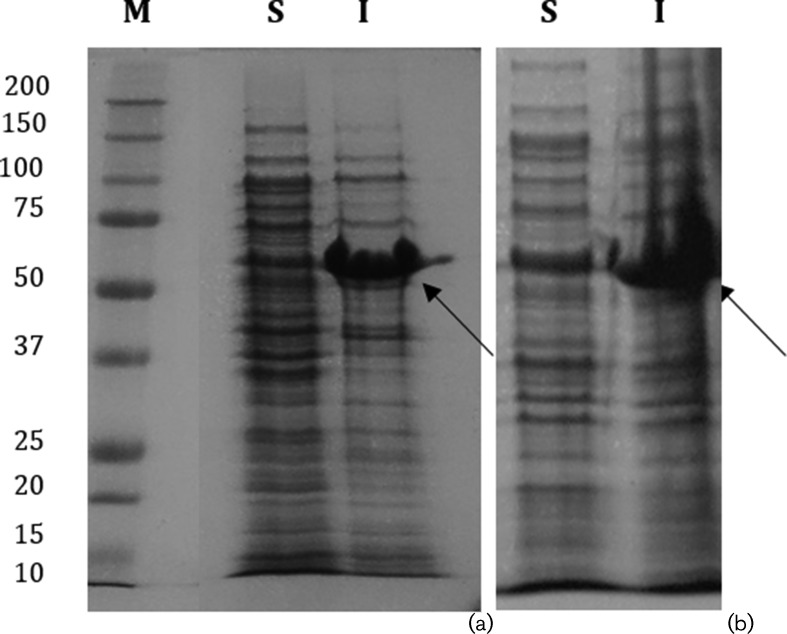
SDS-PAGE analysis of both soluble (S) and the insoluble (I) fractions resulting from the expression of fusions His6MBPBladSP10-5 (a) and His6MBPBladSub5 (b). Molecular masses of standards are indicated in kDa.